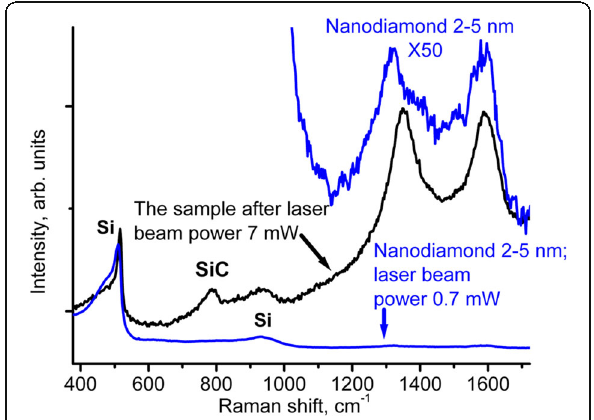
Fig. 3 Raman spectra of the 2 – 5-nm nanodiamond at the 257 and 458-nm excitation wavelengths. Raman spectra compose of peaks at 1325 cm − 1 (with the shoulder around 1250 cm − 1 ), 1600 cm − 1 and the 1500 cm − 1 band observed at 458 nm which shifts to 1630 cm − 1